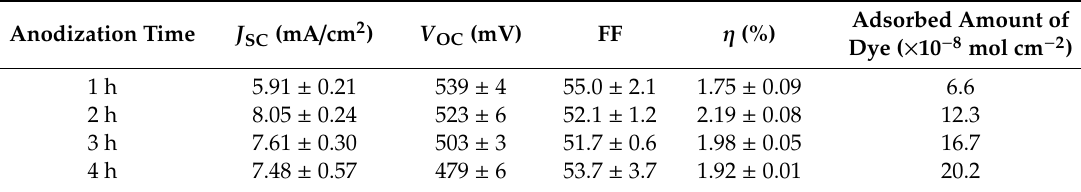
Table 1. Photovoltaic parameters of the dependence on the anodization time for the anodic TiO 2 NT